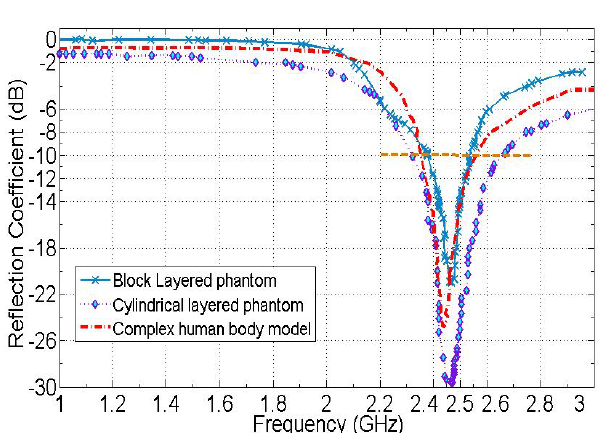
Figure 6: Comparison of relative permittivity and conductivity of the mixed-meat phantom with skin, and muscle.